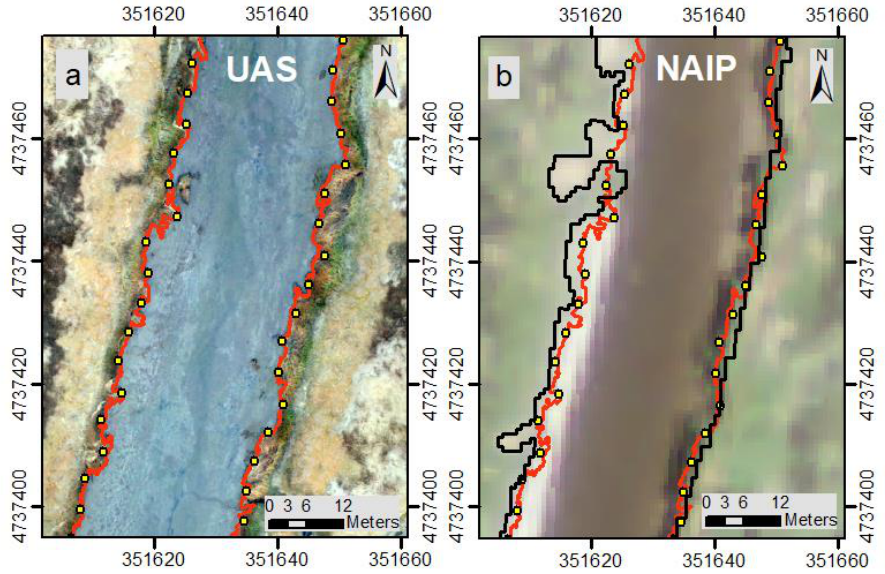
Figure 7. Plum Island, MA (Box 7 in Figure 2) showing ( a ) imagery from UAS; ( b ) imagery from NAIP. Yellow dots: Marsh scarp from MEED, red line: Unvegetated / vegetated line from MEIP using UAS data, black line: Unvegetated / vegetated line from MEIP using NAIP imagery.